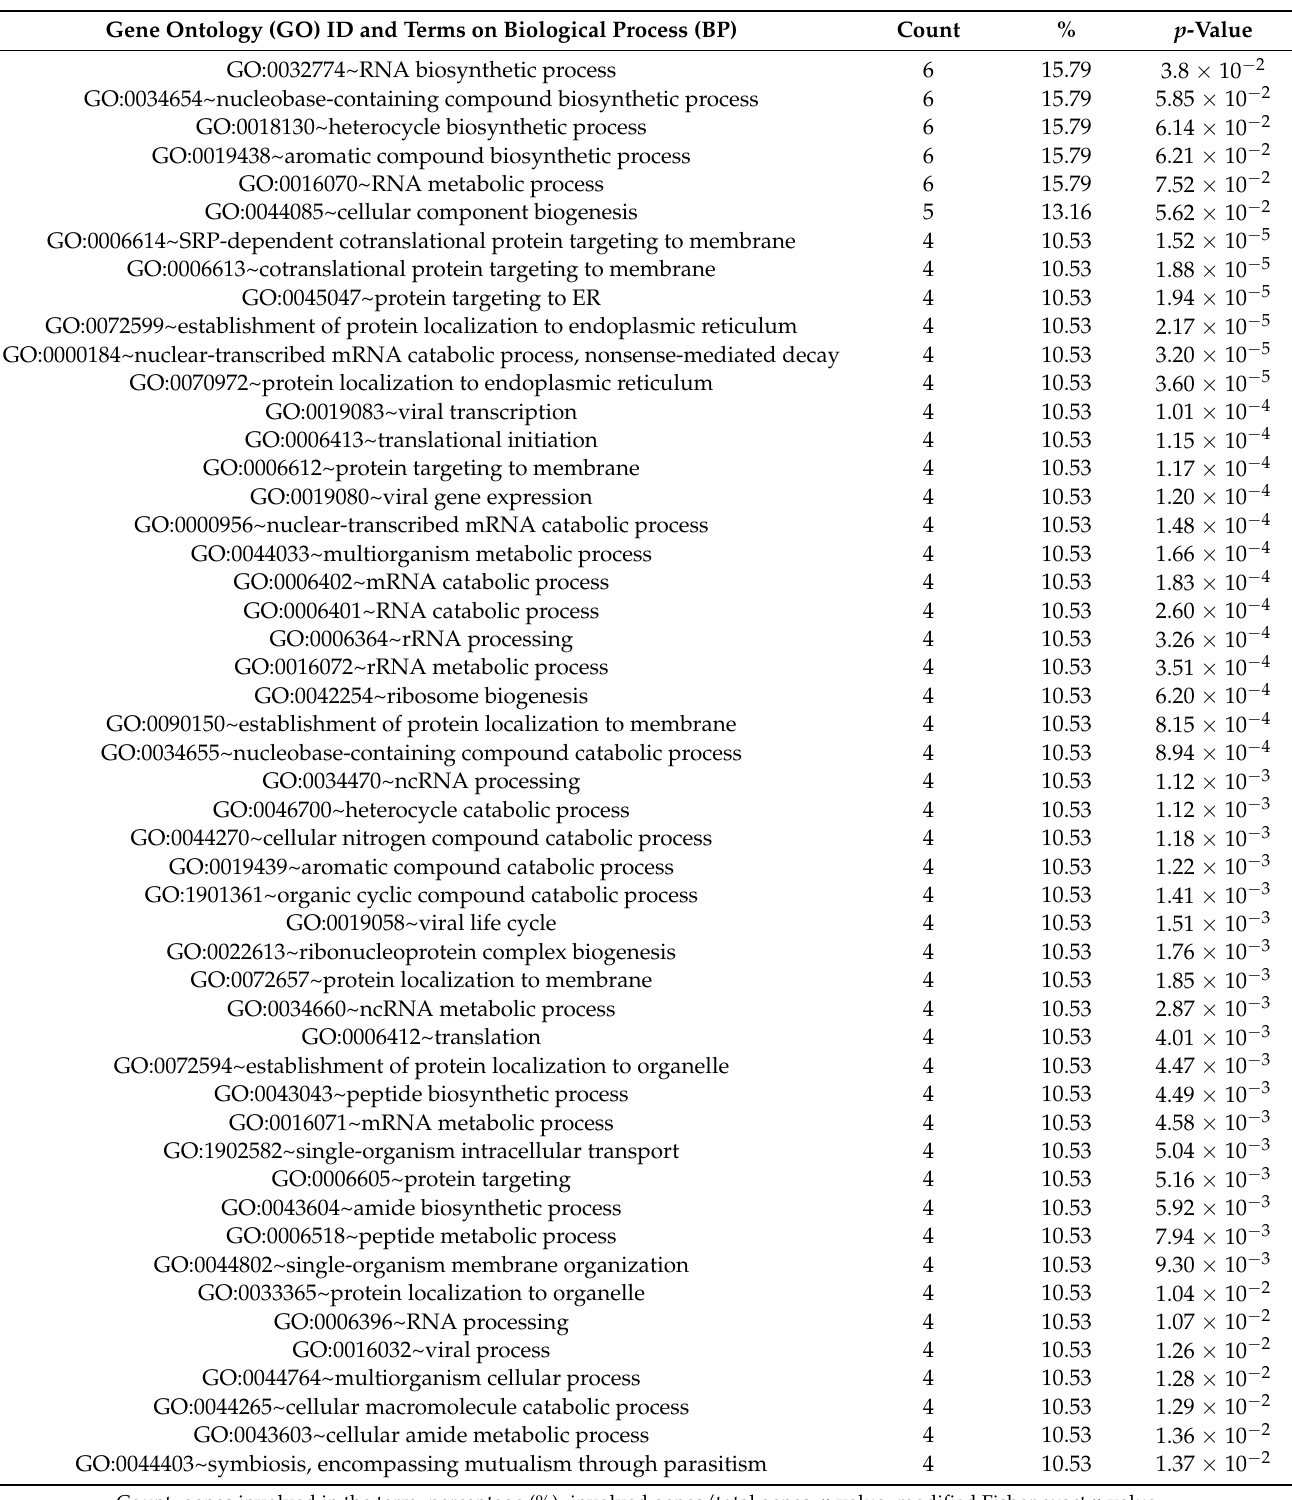
Table 4. The functional analysis of the downregulated genes at 3 h after LLL irradiation. Gene Ontology (GO) ID and Terms on Biological Process